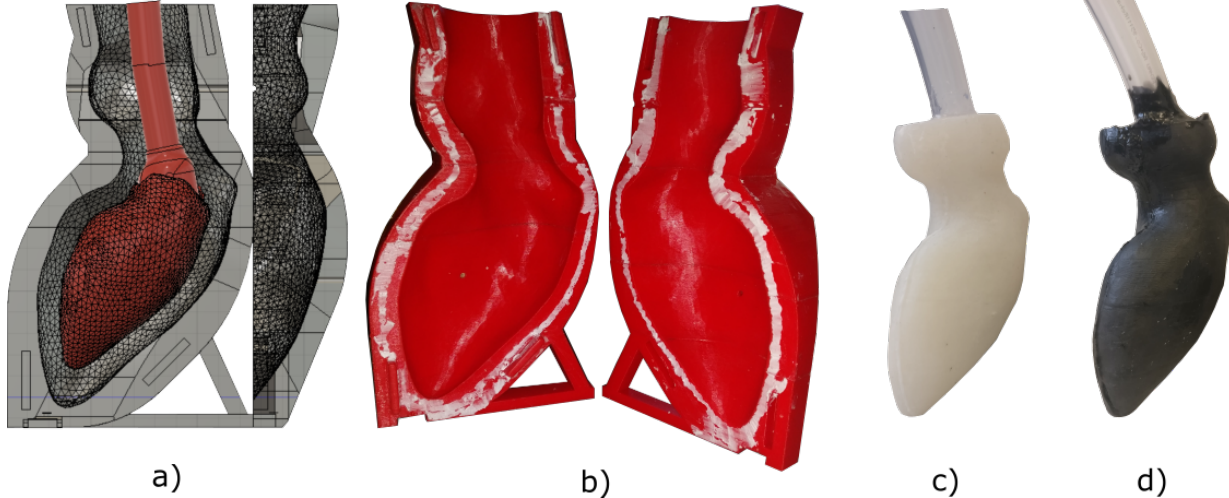
Fig.1: a) CAD model with the inner wax-/ polyvinylalcohol-core; b) 3D-printed casting molds from polylactide; c) Resulting insulating ventricle from silicone; d) Resulting conductive ventricle from silicone and